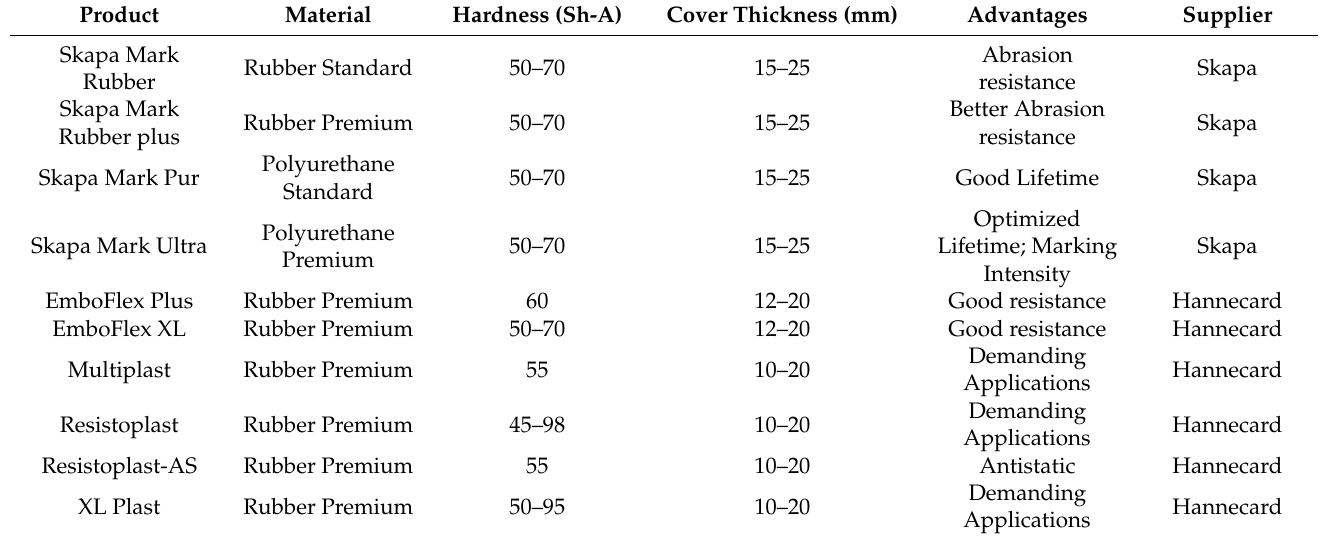
Table 1. Range of hardness and advantages of rubber cover in the embossing process